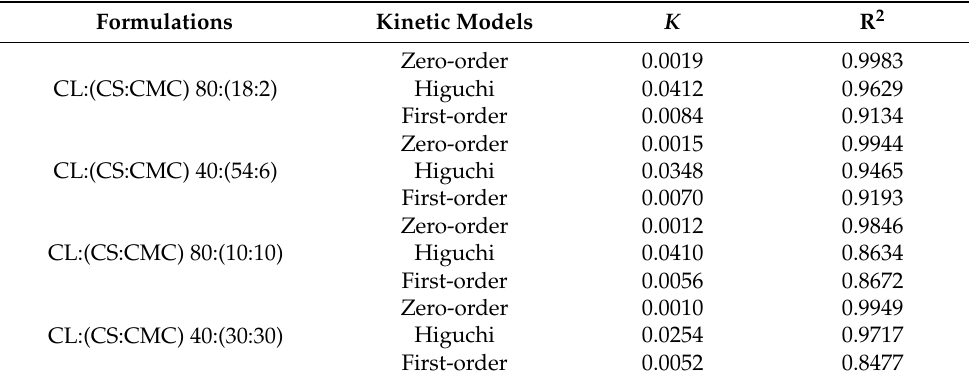
Table 2. Zero-order, Higuchi, and first-order kinetic models applied for clarithromycin release